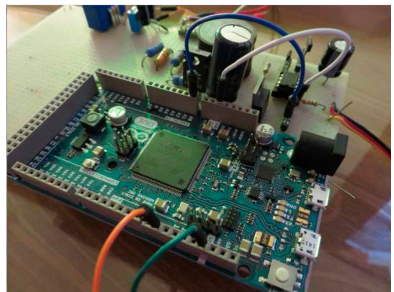
Figure 9. Physical realization of the buck converter.